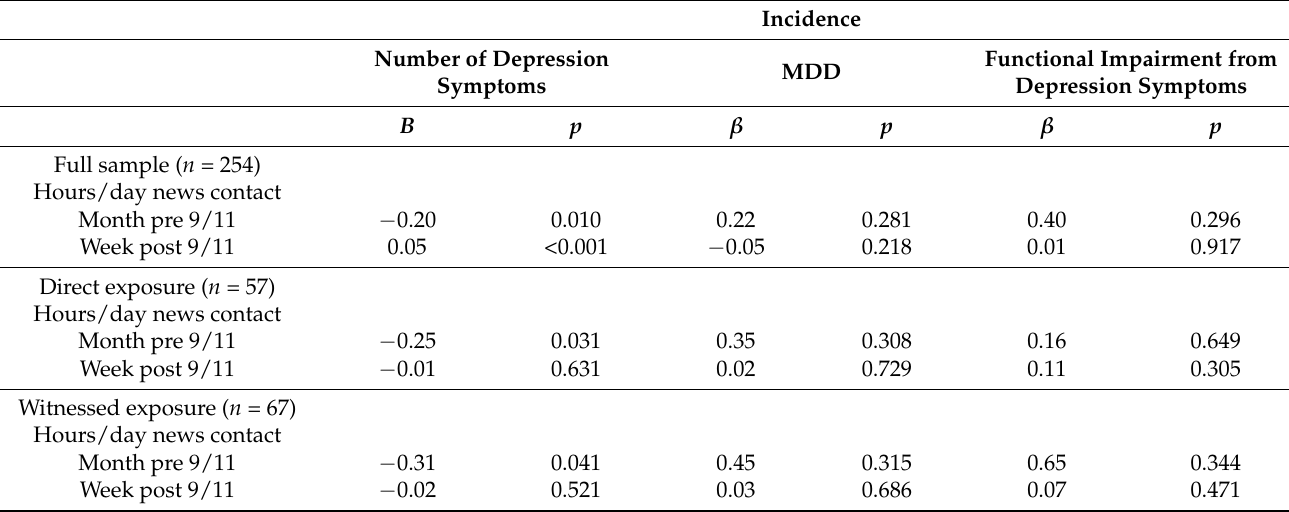
Table 3. Results from Poisson and logistic regression analyses for incident depression